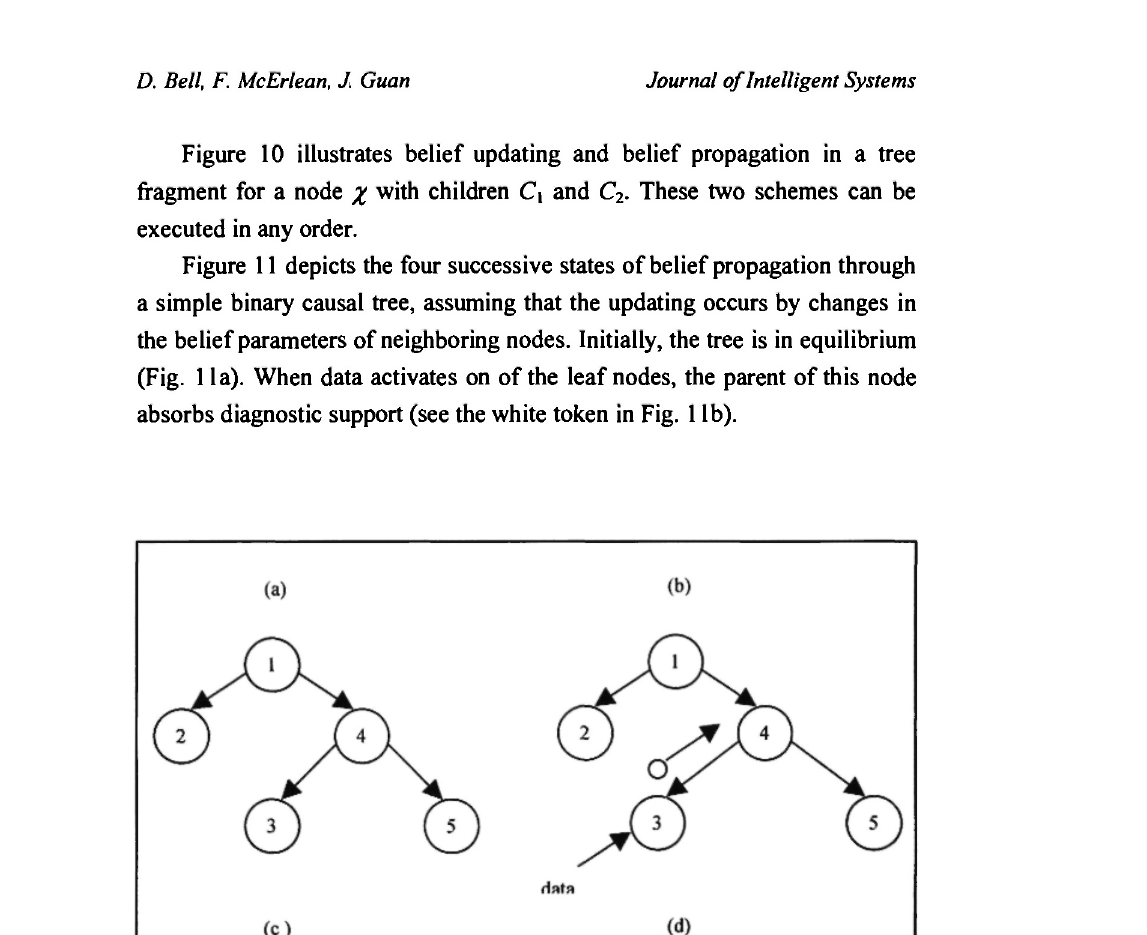
Fig. 11: The three cycles of belief propagation in a 5-node causal tree